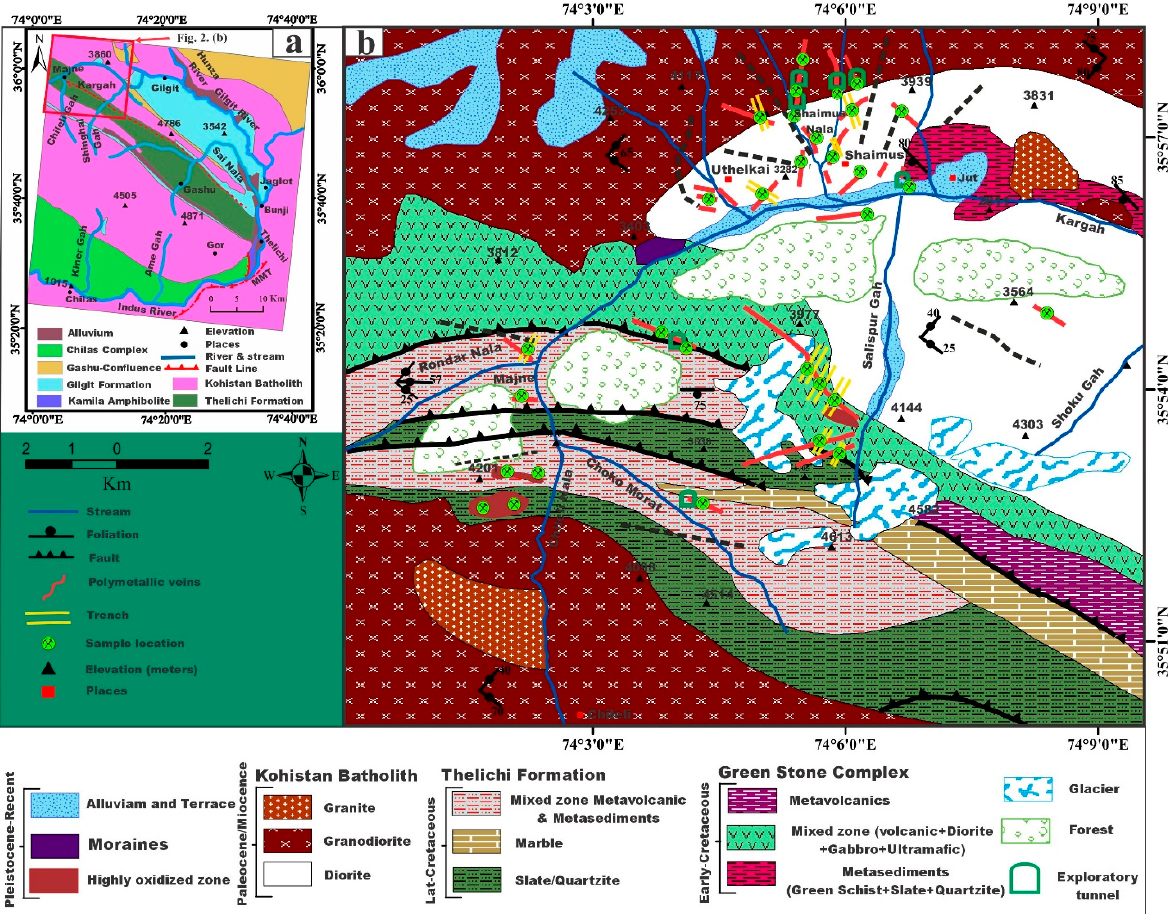
Figure 2. ( a ) Simplified geological map of the Kohistan terrane exposed between Gilgit and Chilas after Khan et al. [20]; ( b ) The local geological map of the Kargah valley was modified from Khan et al. [20] and Khan et al. [22].